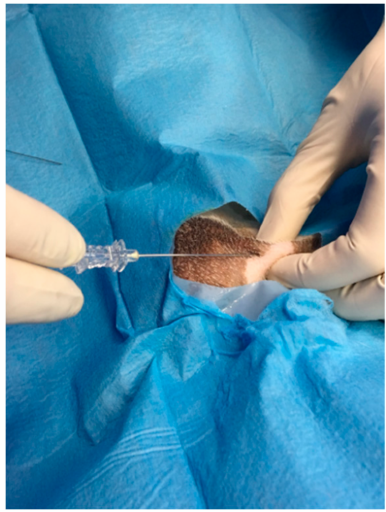
Figure 4. Infiltrative injection of ropivacaine hydrochloride concentrated at 0.5% at the prescrotal incisional